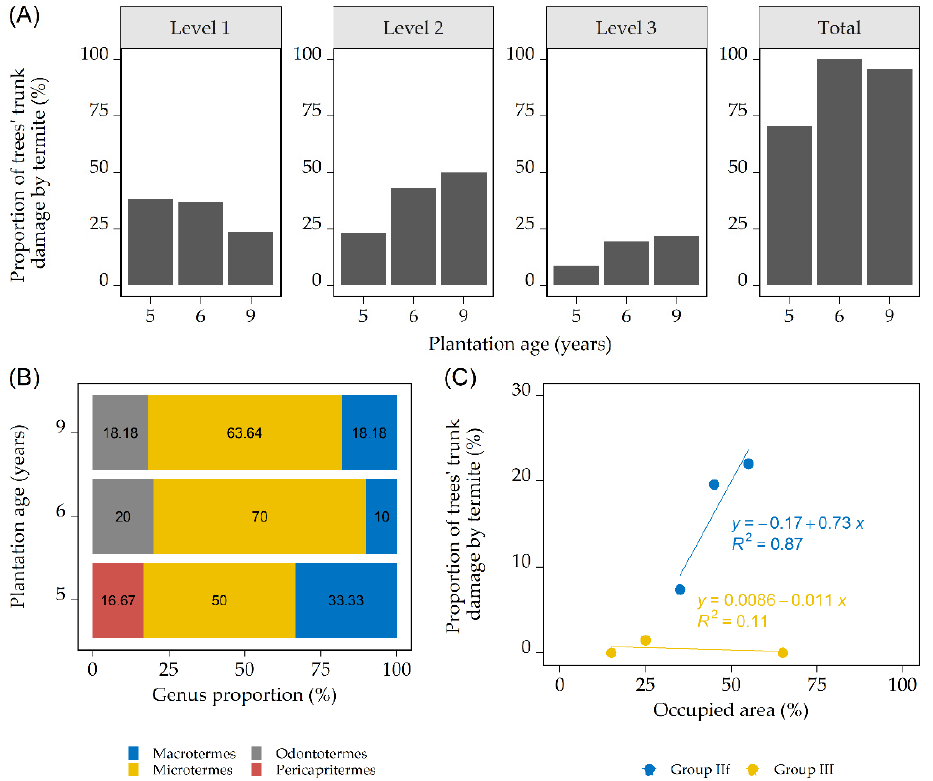
Figure 3. Termite attacks on teakwood trunks. ( A ) Attacks at all three levels of damage and the combined damage from Level 1 to 3; ( B ) the termites collected from teakwood trunks with Level 3 damage; and ( C ) relationship between functional group occupied area and active termite incidence on teakwood trunks with Level 3 damage. See Table 1 for a description of the damage levels caused by termites (Levels 1, 2, and 3).